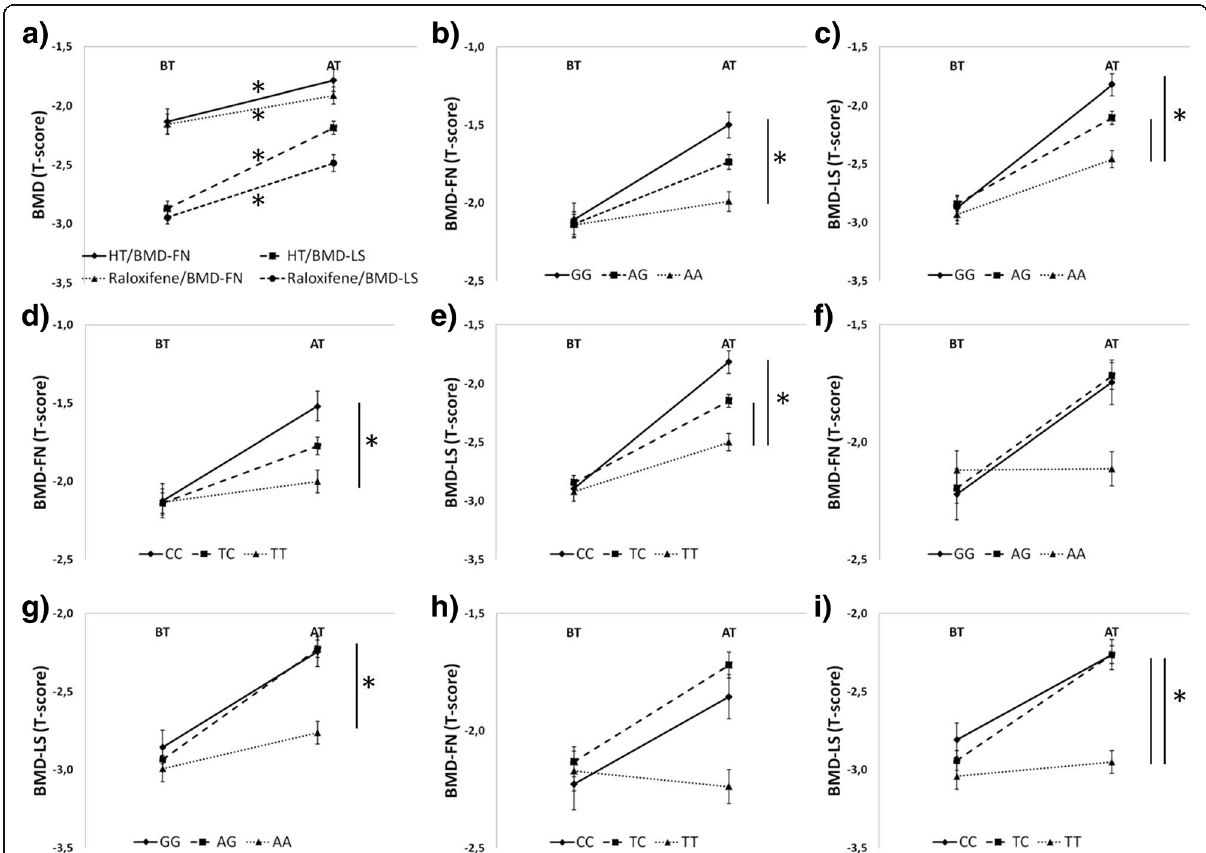
Fig. 2 Effects of the treatment on BMD change. a effect of a treatment type on BMD-FN and BMD-LS change; b-e effect of HT on BMD-FN and BMD-LS change according to the rs2234693 and rs9340799 genotypes; f-i effect of raloxifene treatment on BMD-FN and BMD-LS change according to the rs2234693 and rs9340799 genotypes; BT – before treatment; AT – after treatment; * indicates significant differences ( P